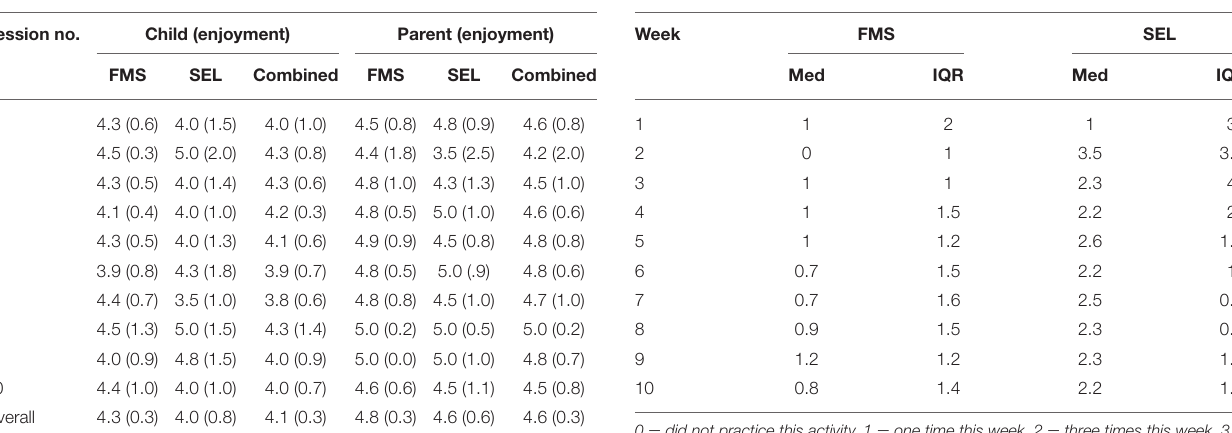
TABLE 5 | Weekly breakdown of parental engagement in take-home activities.